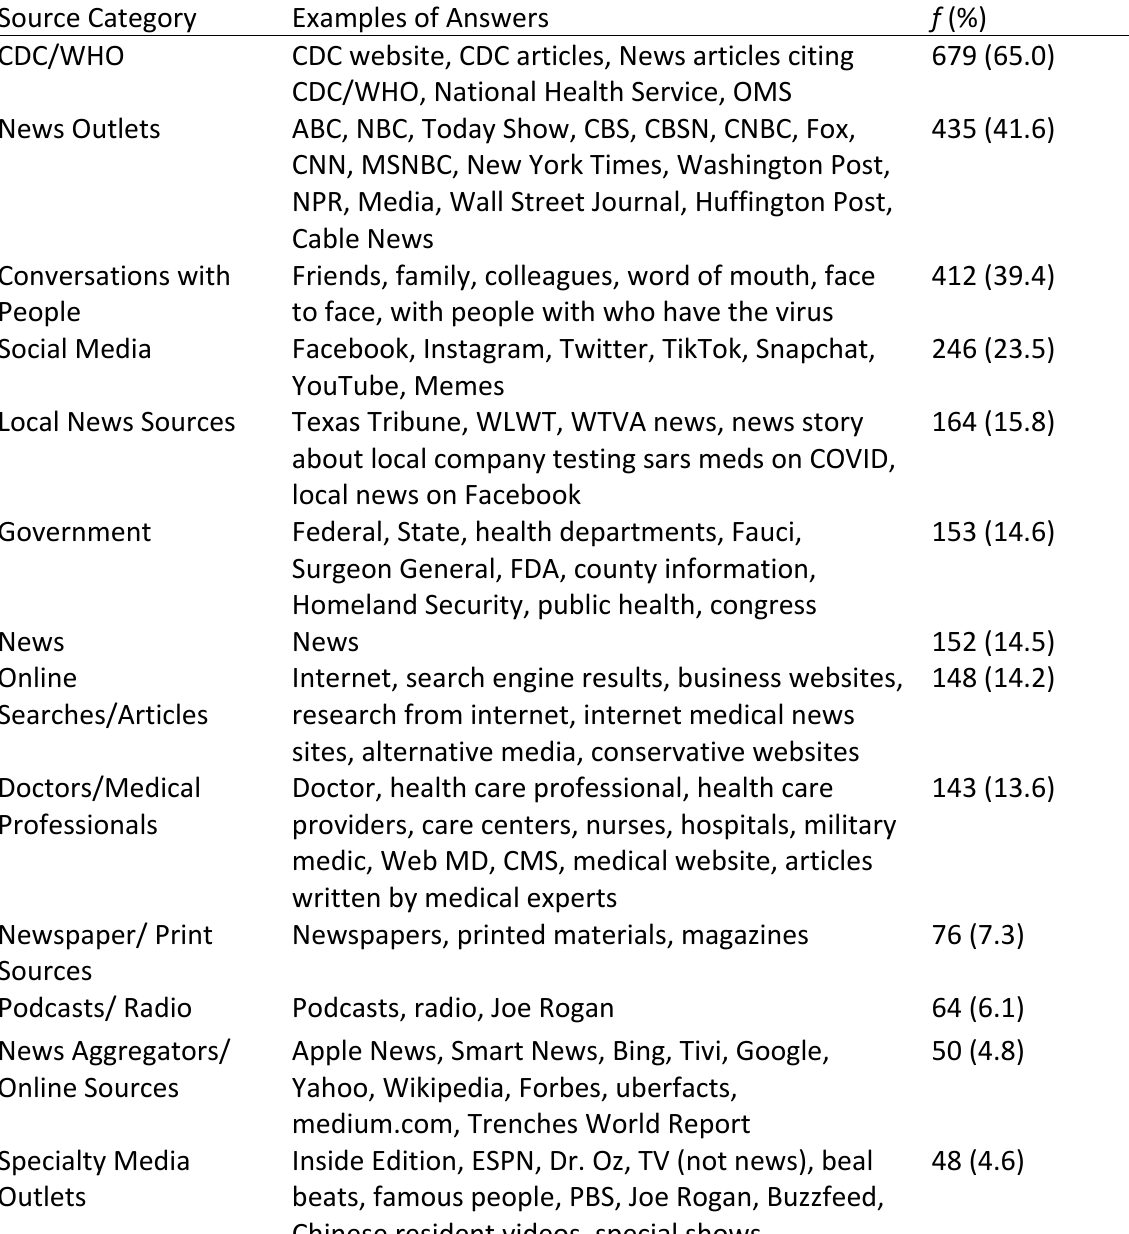
Table 6 Open-ended Responses for Three Sources Used by Respondents Who Indicated They Had Shared Information about COVID-19 in the Early Stages of The Pandemic (n =